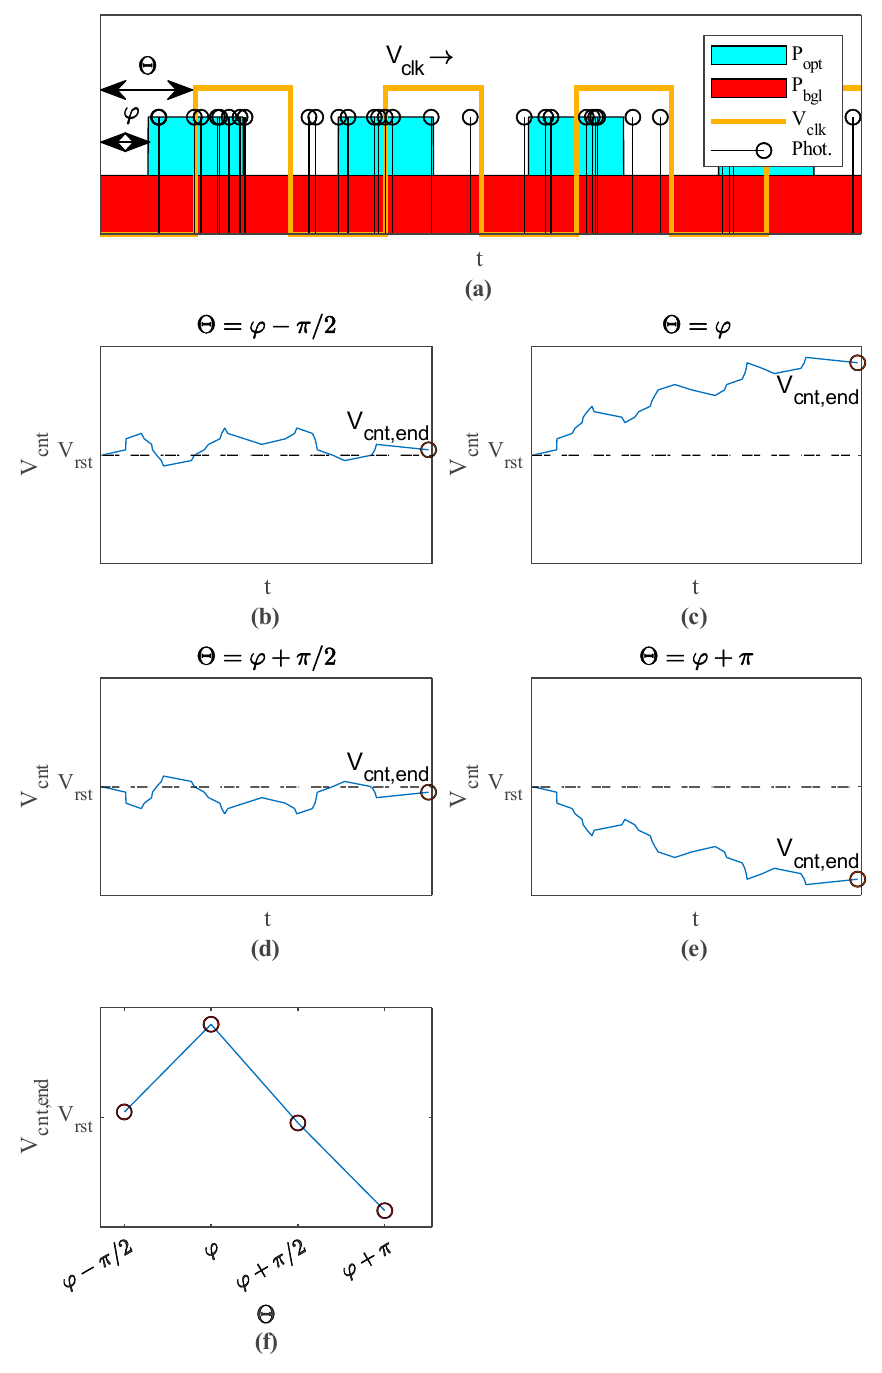
Figure 2. Basic principle of iTOF measurement with our correlation approach: ( a ) probabilities for receiving a signal photon pulse P opt or a background light photon pulse P bgl with shown photon pulses and V clk over time t ; ( b–e ) integration of these photons for four different phase steps Θ with plotted V cnt over t ; ( f ) V cnt end values merged to a correlation triangle.